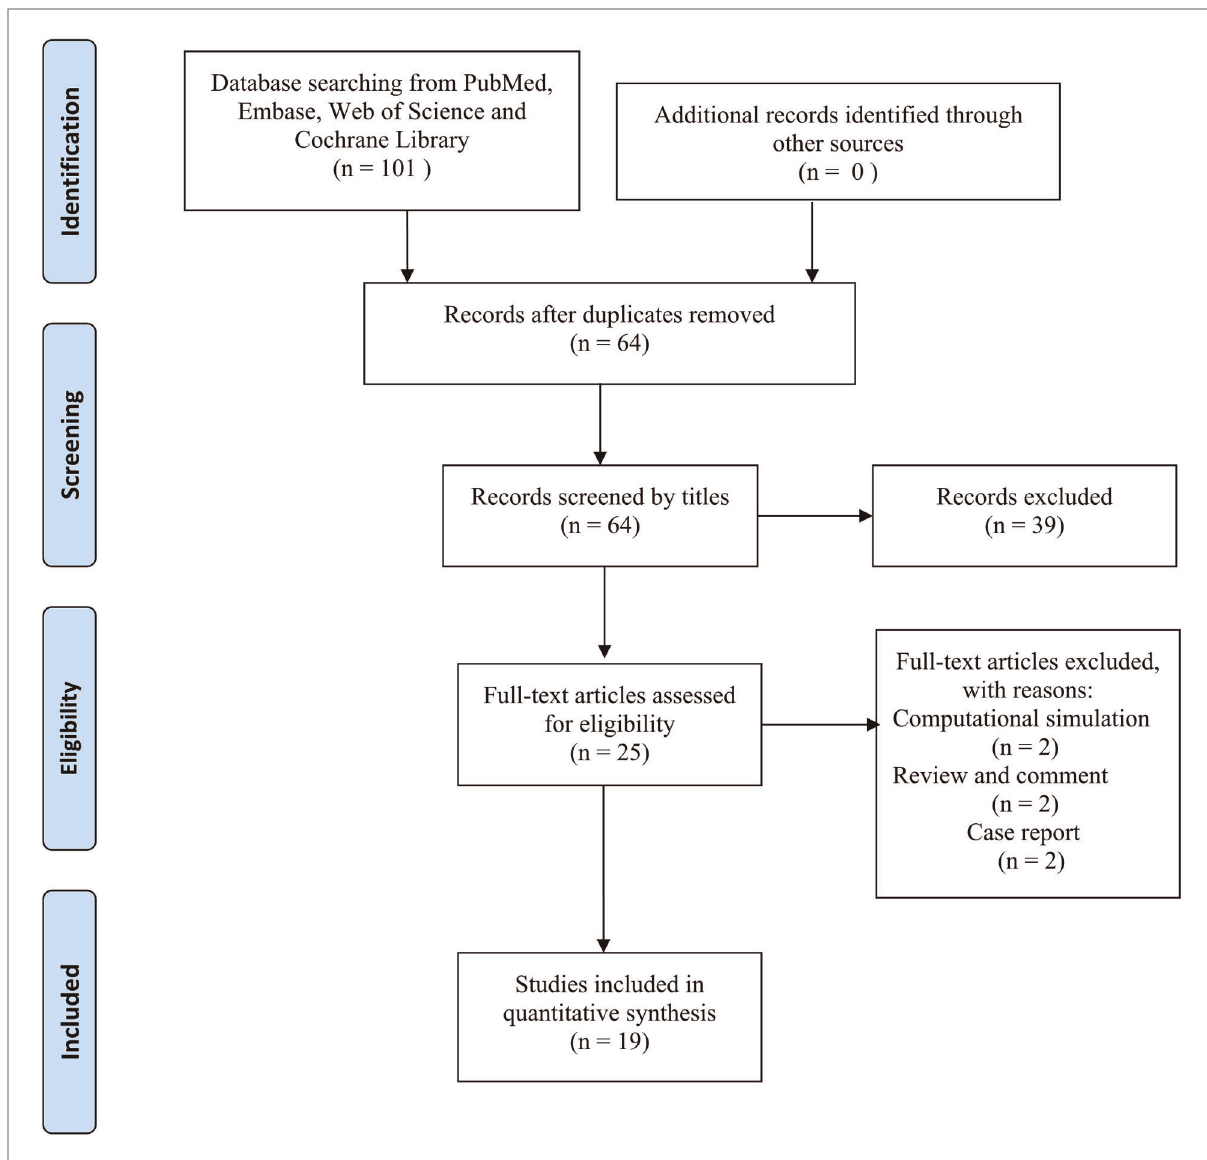
FIGURE 1 PRISMA fl ow